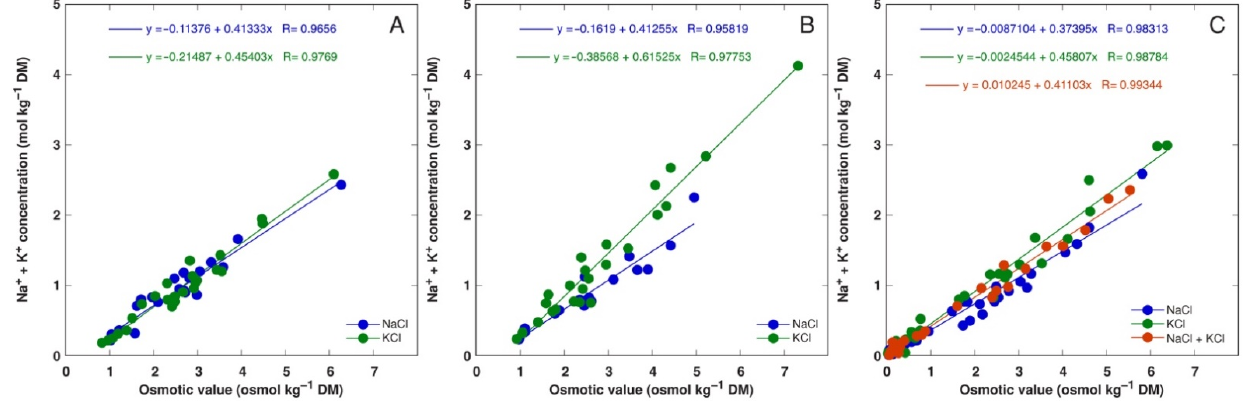
Figure 11. Relationship between Na + + K + concentration and osmotic value in all parts of Armeria maritima accessions AM1 ( A ), AM2 ( B ) and AM3 ( C ) treated with different salts. DM, dry mass.